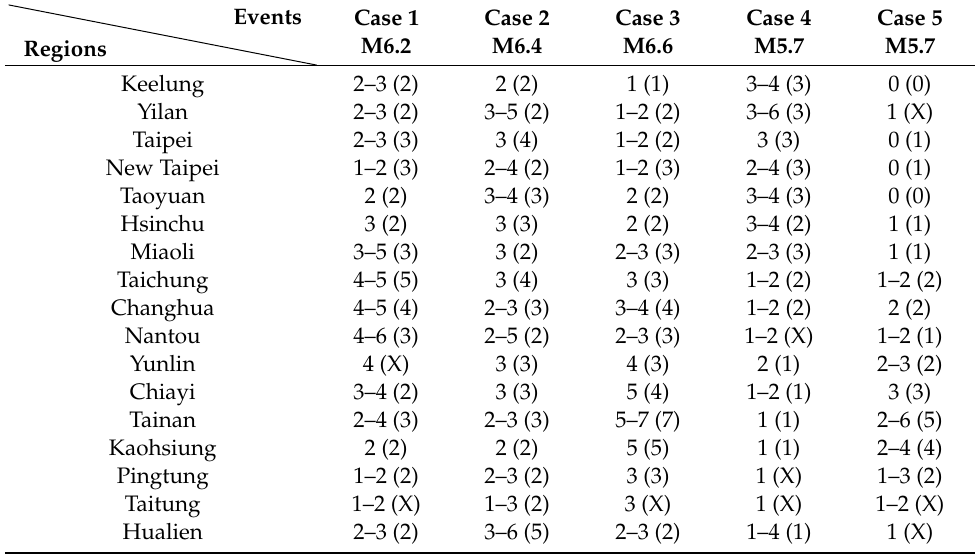
Table 4. Summarization of the scale level for the model estimated and the CWB o ffi cial